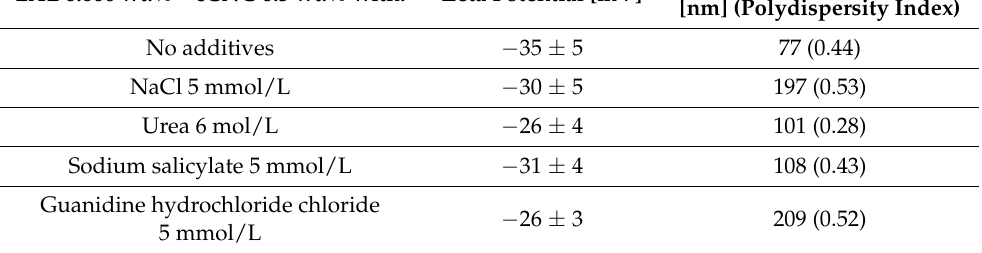
Table 3. Zeta potential and hydrodynamic diameter of cCNC dispersions of LAE 0.006% and additional compounds.